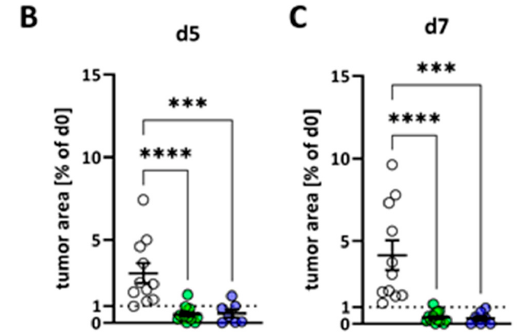
Figure 9. Ex vivo tumor growth assay using organotypic brain slice cultures in the absence (DMSO) or presence of 5 µM of 1 or 2 . ( A ) Growth curves of the NCH644 GFP+ tumors over time after treatment with solvent (DMSO, black line) or 5 µM 1 (green line) or 2 (blue line) normalized to the tumor size one day after transplantation (d0) depicted as mean +/ − SEM. ( B , C ) Point plots of the data summarized in ( A ) after treatment for ( B ) 5 days or ( C ) 7 days). Dashed line on y = 1 display the original tumor size. ***: p < 0.001; ****: p < 0.0001; two-Way ANOVA with Tukey’s multiple comparisons test (GraphPad Prism 7).